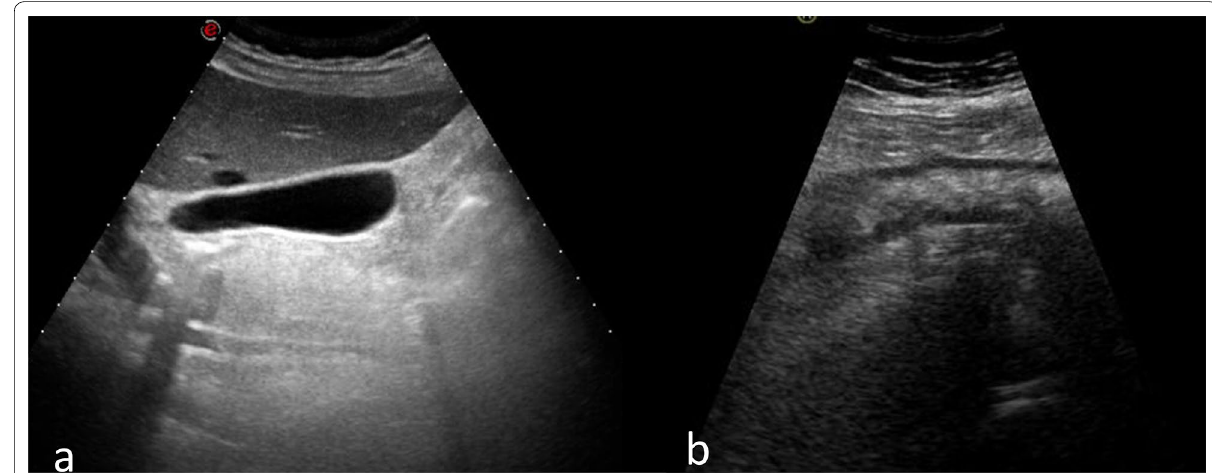
Fig. 1 The ultrasound demonstrated normal liver, spleen, kidneys, no free fluid and normal gall bladder ( a ). A diffuse wall thickening of the bowel in the right upper quadrant ( b ). The impression was of a right-sided inflammatory bowel disease or colon